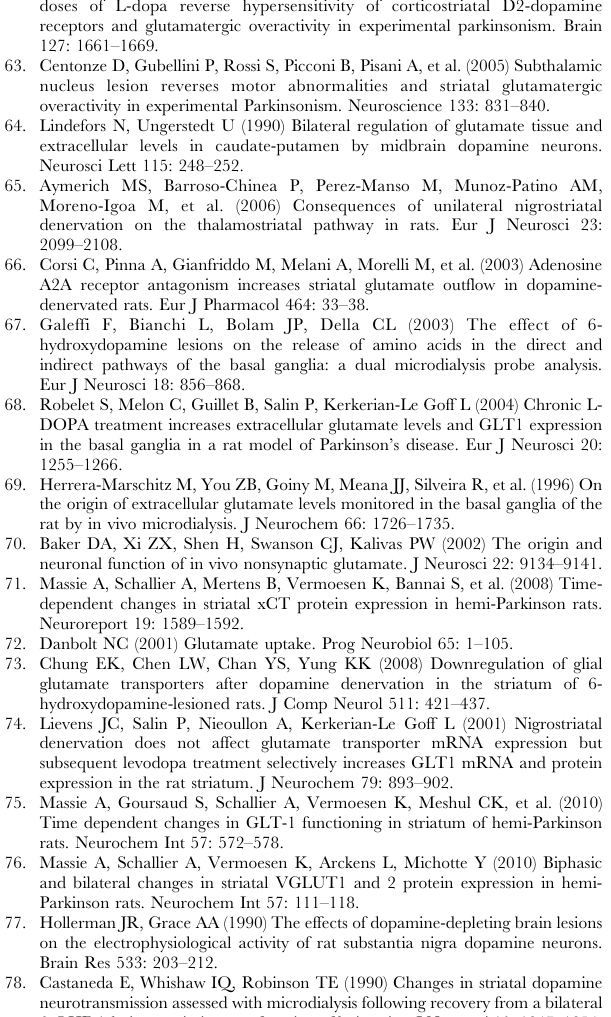
6-OHDA lesion: variation as a function of lesion size. J Neurosci 10: